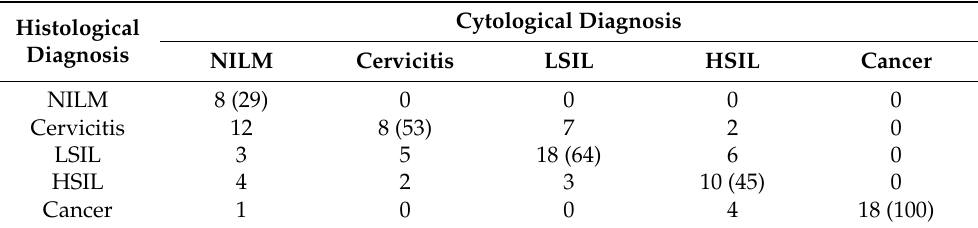
Table 1. Contingency table for diagnoses of cervix lesions established by cytology and histology. Number of patients and respective accuracy (%). The accuracy of each diagnosis is indicated in parentheses, calculated as the ratio of the number of true cases of any cytological diagnosis to the total number of cases with such a cytological diagnosis.